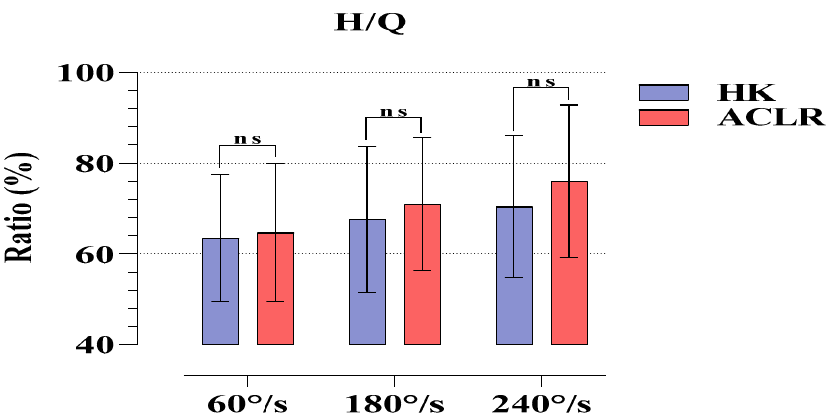
Figure 2. Comparison of H/Q ratios obtained in isokinetic tests for HK and ACLR. ns, non- significant; HK, healthy knee; ACLR, anterior cruciate ligament reconstruction knee; H/Q, ham- string/quadriceps.